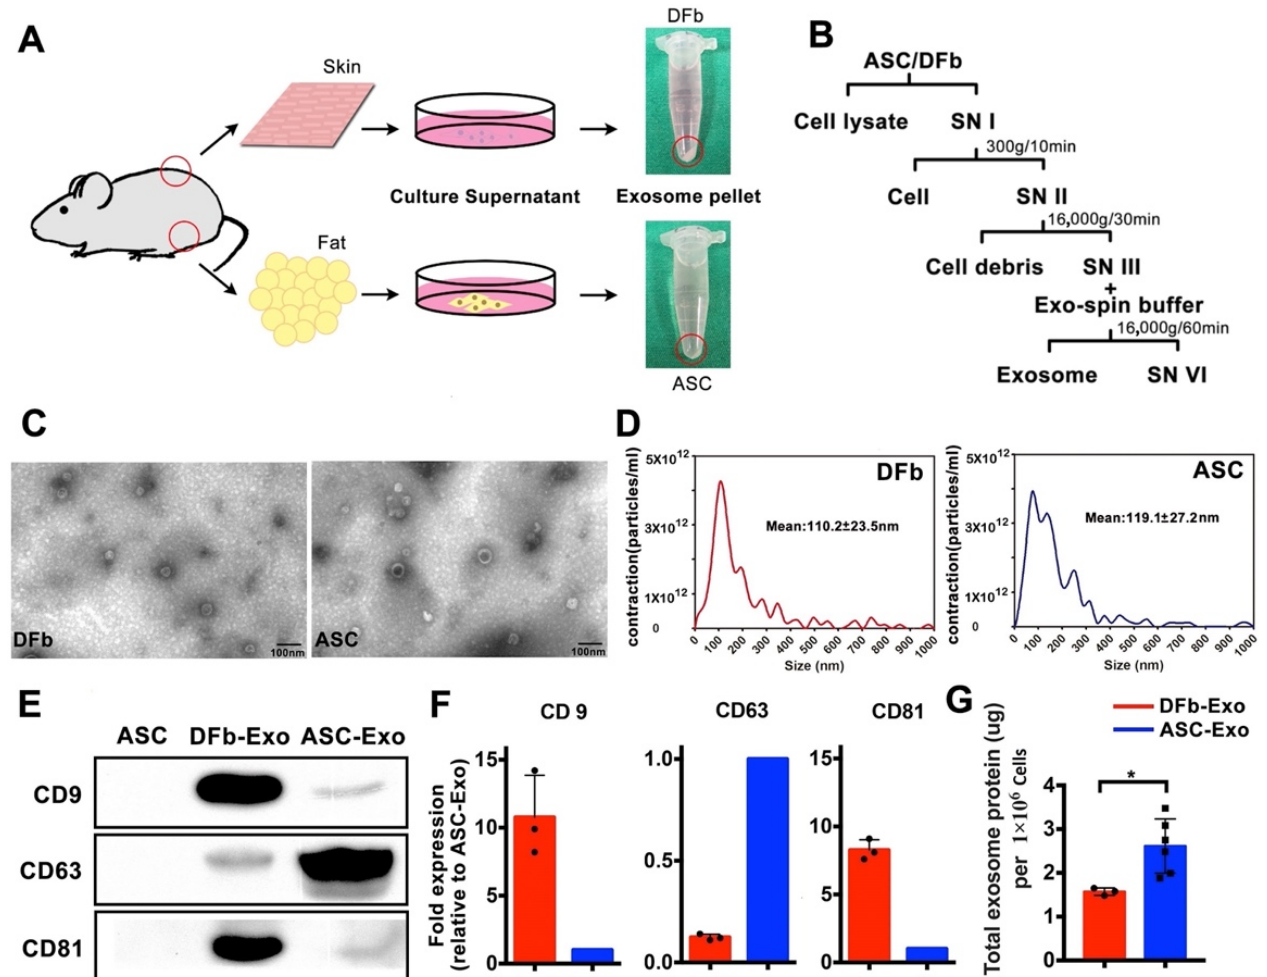
Figure 1. Characterization of dermal fibroblast (DFb) and adipose stem cell (ASC) derived exosomes. ( A ) Schematic illustrating the workflow used to generate exosomes. The arrows indicate harvested dermal fibroblast or adipose stem cell-derived exosome pellets; ( B ) differential centrifugation procedure for the isolation of exosomes from DFb and ASC culture supernatants (SN); ( C ) transmission electron microscopic morphological analysis of ASC-Exo and DFb-Exo depicts multiple cup-shaped and shrunken vesicles in the conditioned medium (scale bar: 100 nm); ( D ) size distribution of ASC-Exo and DFb-Exo based on NanoSight nanoparticle tracking analysis (NTA). Statistics of the size of ASC-Exo and DFb-Exo based on NTA are shown as mean ± SD (representative result of four independent analyses); ( E ) Western blot analysis of general exosome markers, including CD9, CD63, and CD81 for ASC-Exo and DFb-Exo; ( F ) semi-quantification analysis of CD63, CD9, and CD81 expression from ASC-Exo and DFb-Exo; ( G ) total protein contained within exosomes isolated from the culture supernatant of 1 × 106 dermal fibroblasts ( n = 3) and adipose stem cells ( n = 6). * p < 0.05. Error bars are mean ± SE. Data were analyzed using independent unpaired two-tailed Student’s t - tests.